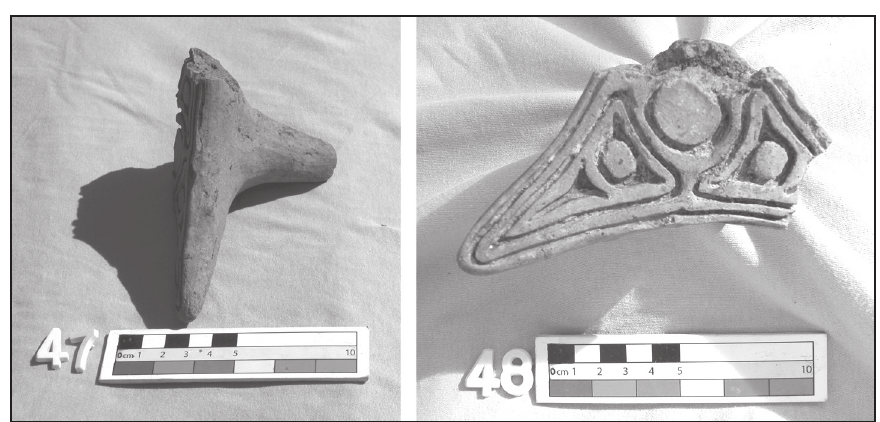
Figure 2. Incised ceramic stamp (12cm wide, 7cm deep) (No. 04CGB000448).